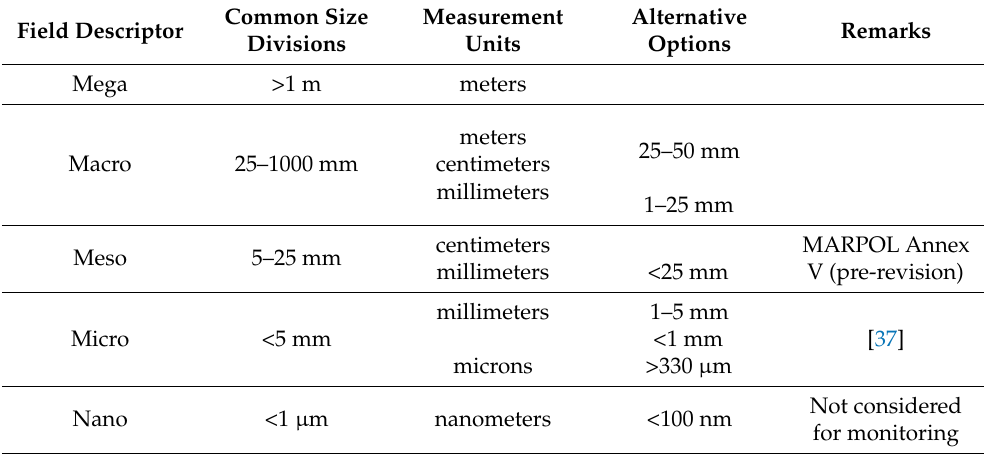
Table 1. Size categories of plastic marine litter, assuming a near-spherical form, showing common definitions and alternative options that may be appropriate for operational reasons from